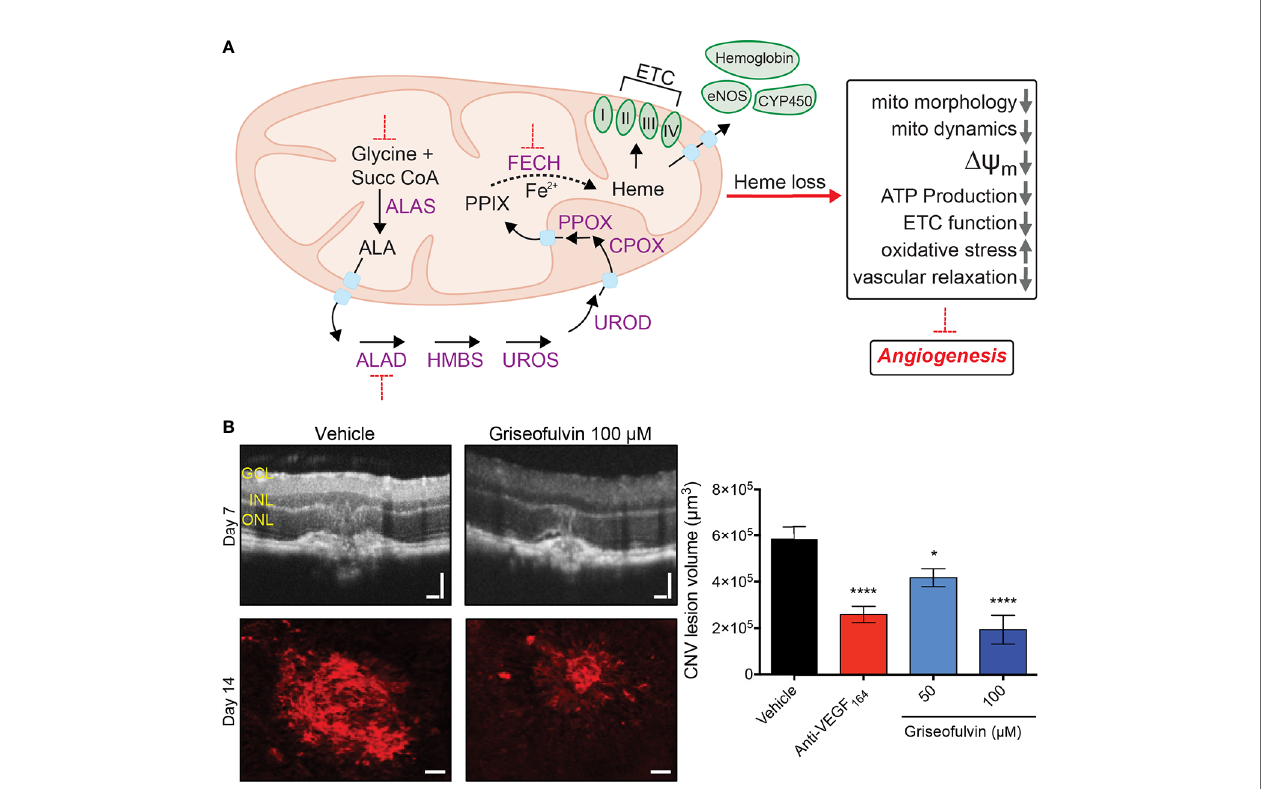
FIGURE 1 | Schematicdiagram of the heme synthesispathway inthe mitochondrionand effect of Fech inhibition invivo . (A) Eight sequential stepsin the heme synthesis pathway are depicted,alongwith some heme-containing proteins. Red dotted lines indicate blockade. (B) Fech inhibition usinggriseofulvin inthe laser-induced choroidal neovascularization (CNV) mouse model. CNVwas con fi rmed byoptical coherence tomography (OCT). Griseofulvin treatedeyes hadsigni fi cantly smaller neovascular lesions as seen in red agglutinin staining for vasculature. Retinallayers indicated: GCL, ganglion celllayer; INL, inner nuclear layer, ONL, outer nuclear layer;Scalebars for OCT images and agglutinin immunostaining are100 and 50 µm, respectively. *p= 0.015; ****p = 0.0001 versusvehicle, ANOVA with Dunnett ’ s posthoc tests (n = 11 – 13 eyes per group).Anti-VEGF 164 isa positive control antibodytherapy. Figure modi fi edfromBasavarajappa et al., 2017 © 2017 The Authors, CC BY4.0. Succ CoA, succinyl-CoA, ALA, 5-aminolevulinic acid; ALAS, ALAsynthase; ALAD,ALA dehydratase; HMBS, hydroxymethylbilane synthase; UROS, uroporphyrinogen synthase; UROD, uroporphyrinogen decarboxylase; CPOX, coproporphyrinogen oxidase; PPOX, protoporphyrinogen oxidase; FECH, ferrochelatase; PPIX, protoporphyrin IX;eNOS, endothelial nitric oxide synthase; CYP450, cytochrome P450; ETC, electron transport chain; DY m = mitochondrial membrane potential;mito,